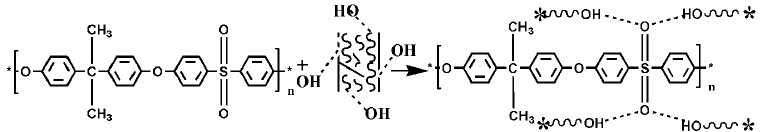
Figure 7. Schematic representation of the intermolecular interactions between the components in LCN/PSF ultrafiltration membranes ( * denotes LCN, ~ denotes cellulose chains, and — denotes lignin chains).